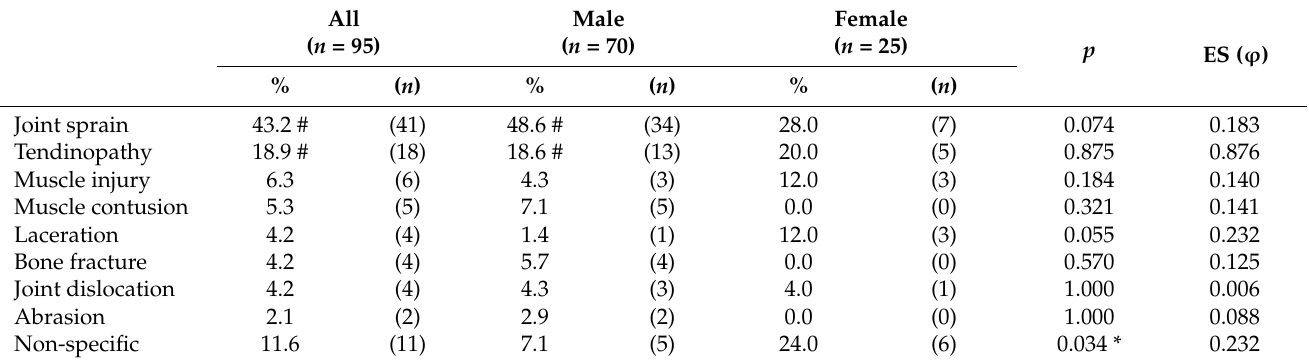
Table 3. Diagnosis of injuries in male and female trail